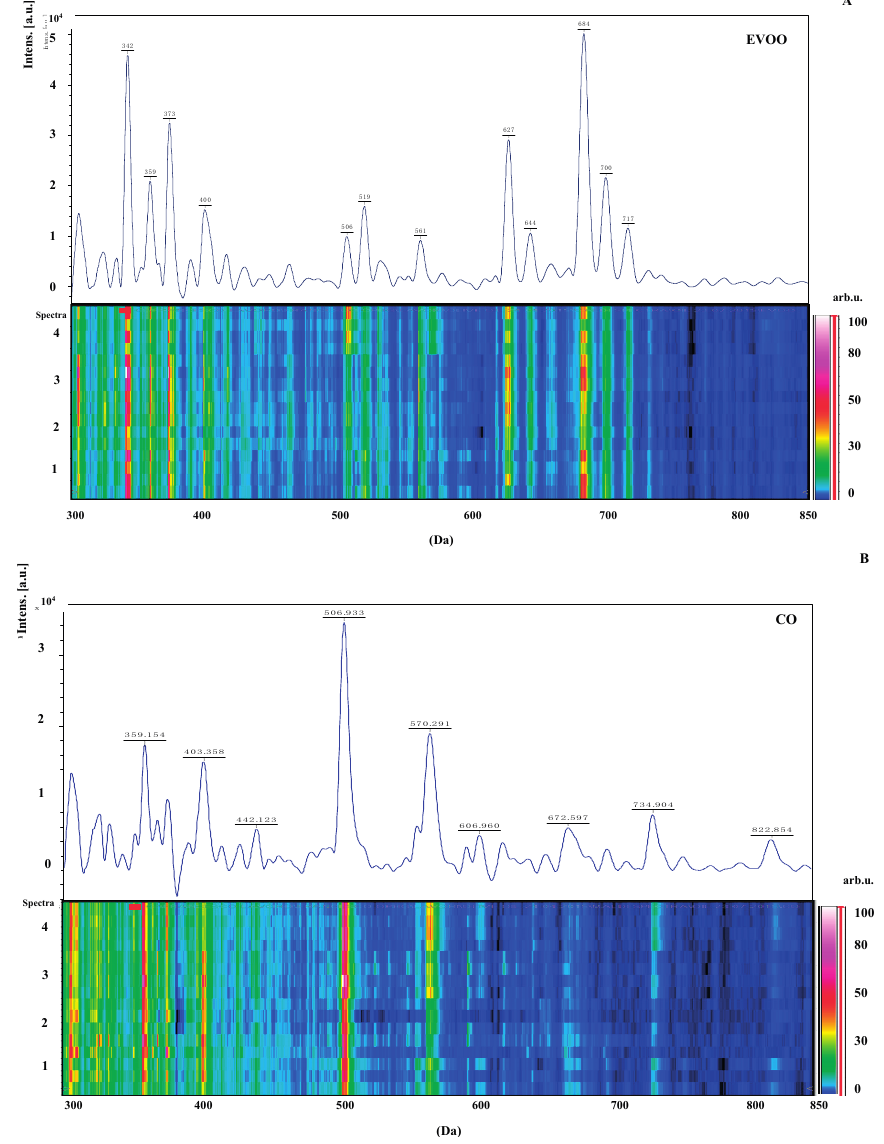
Figure 1. Pseudo-gel like and MALDI-TOF MS lipid profiles of EVOO ( A ) and CO ( B ). The mass values ( m / z ) are reported on the X -axis, while the color bar on the Y -axis indicates the peak intensity. Discriminating mass peaks have m / z values below